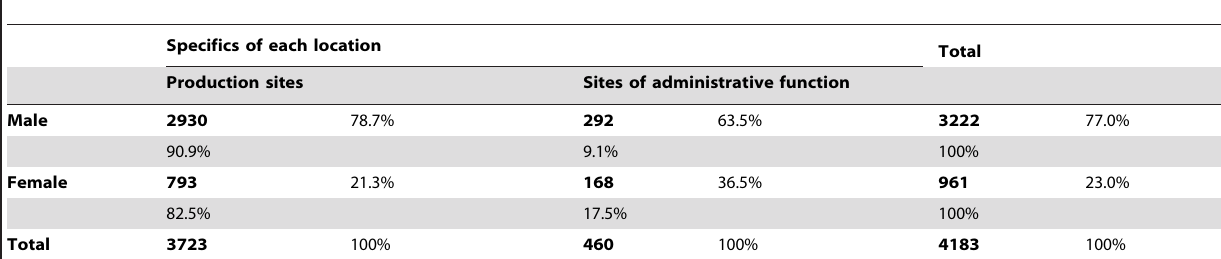
Table 6. Distribution of gender subdivided in production sites and sites of administrative function (n= 4183).